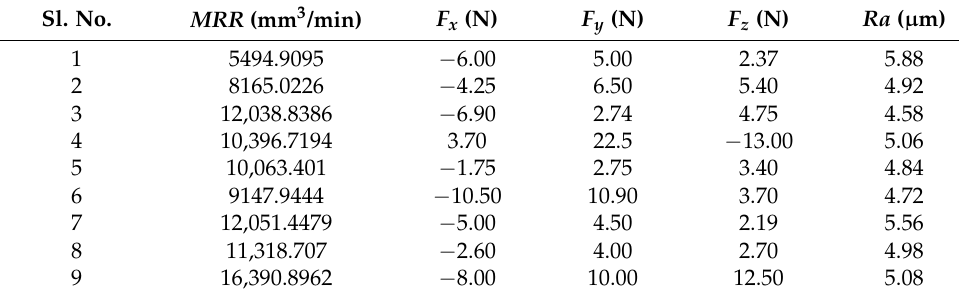
Table 5. Resulted values using Taguchi L9